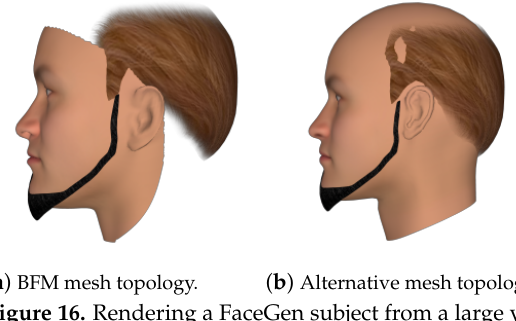
Figure 16. Rendering a FaceGen subject from a large yaw anglewith two different mesh